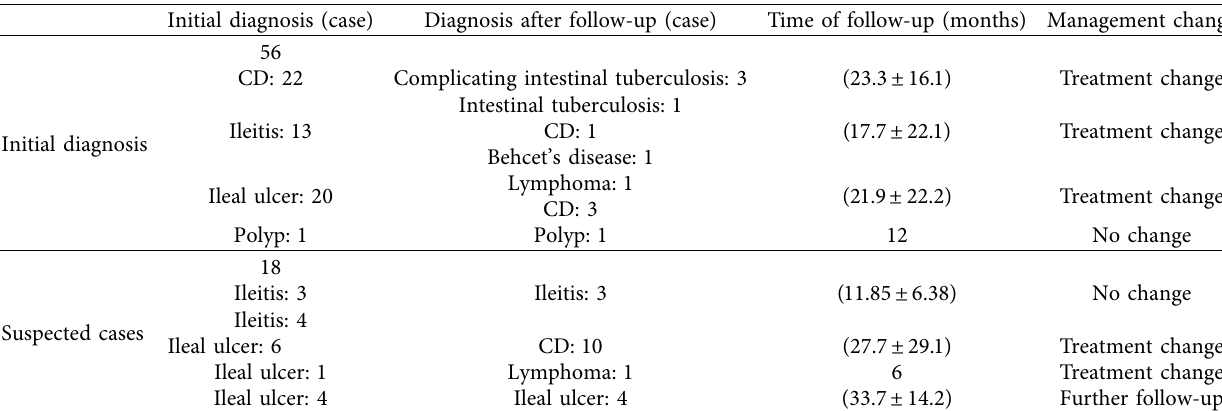
Figure 2: Follow-up of patients with terminal ileum lesions (case). Table 4: Follow-up of patients with terminal ileum